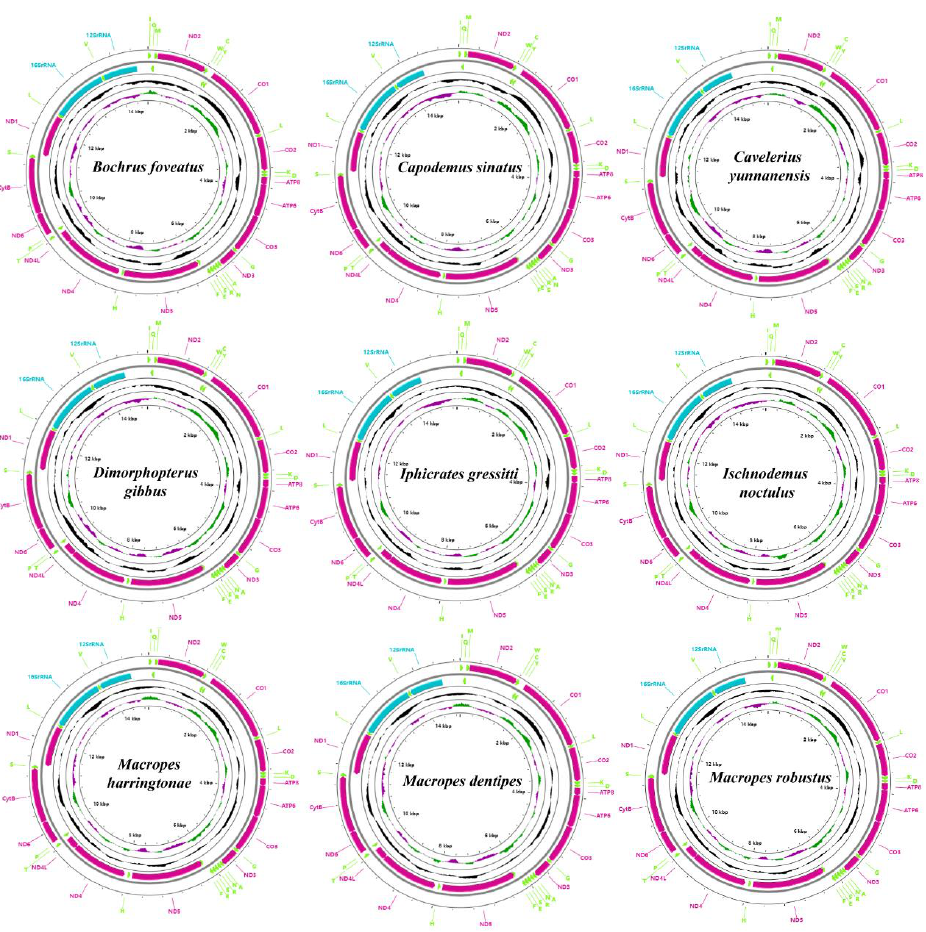
Figure 1. Structure of the mitogenomes’ nine species. Arrows indicate the orientation of gene transcription. Ticks in the inner circle indicate sequence length.